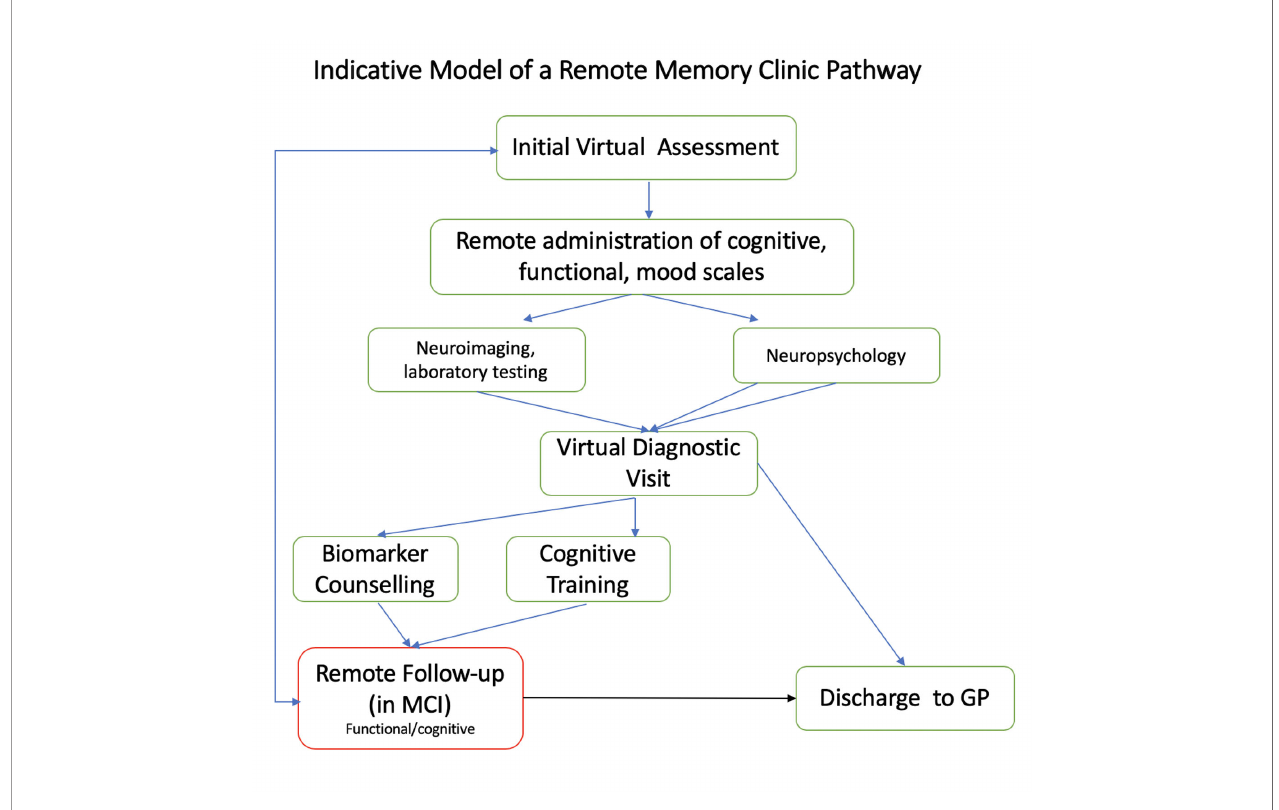
FIGURE 2 | Potential clinical pathway for remote memory clinics. GP, general practitioner; MCI, mild cognitive